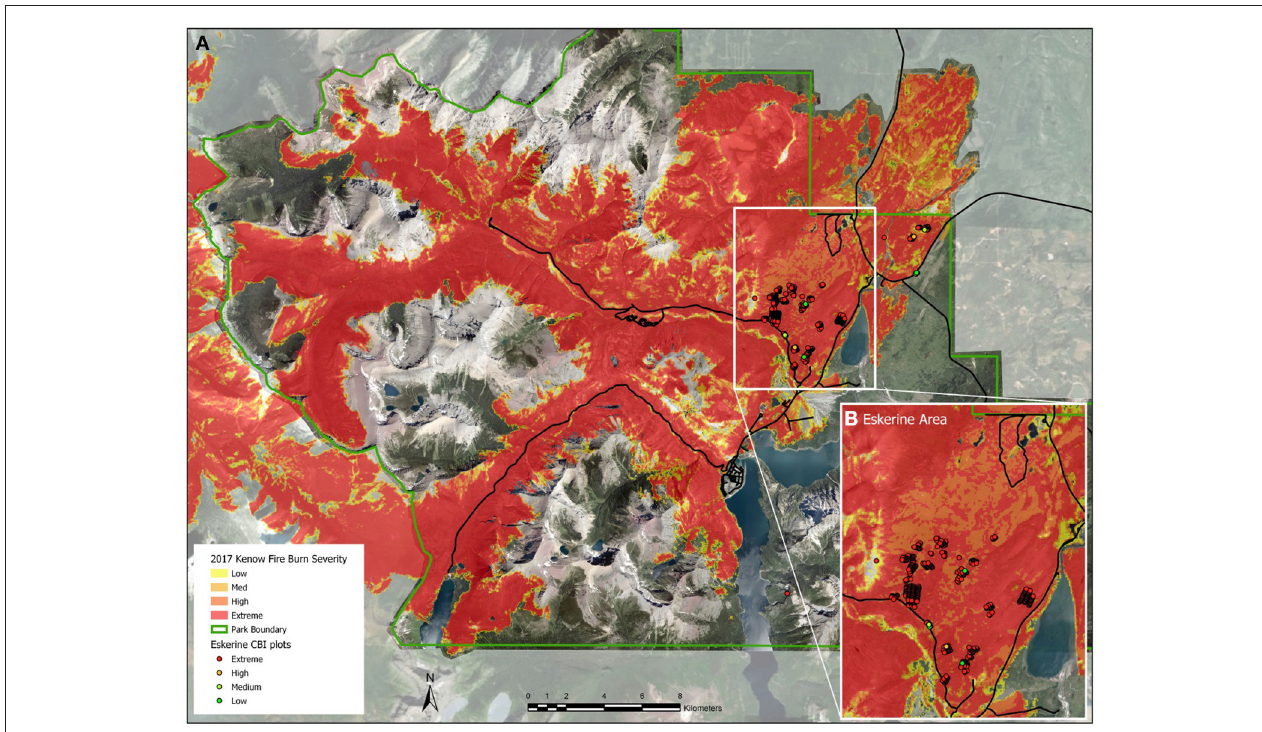
FIGURE 2 | Kenow wildfire fire severity. (A) Fire severity of Waterton Lakes National Park derived from Landsat 8 dNBR values. Threshold dNBR values for Low, Medium, High, and Extreme are 99–270, 271–440, 441–660, and > 660, respectively. Inset map shows the Eskerine Complex area, with CBI plot locations; and (B) Fire severity detail for the Eskerine Complex, maps by Adam